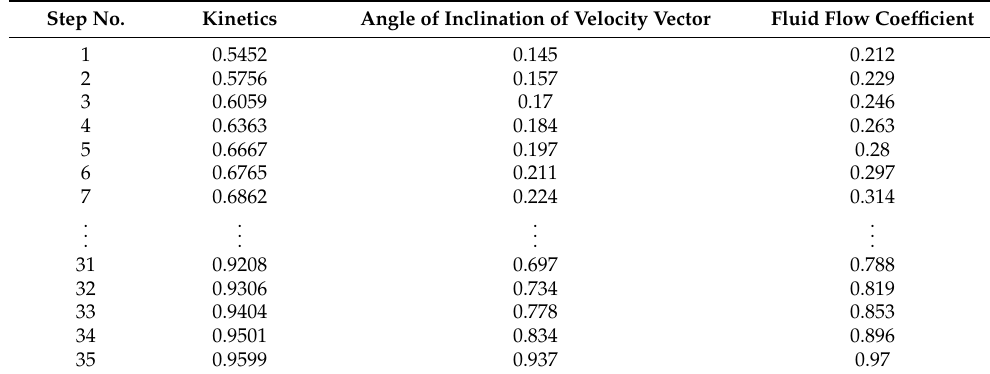
Table 3. Kinetics, slope angle of the fluid velocity vector to the OX axis and flow coefficients at the points on the characteristic M 0 M n (area III).